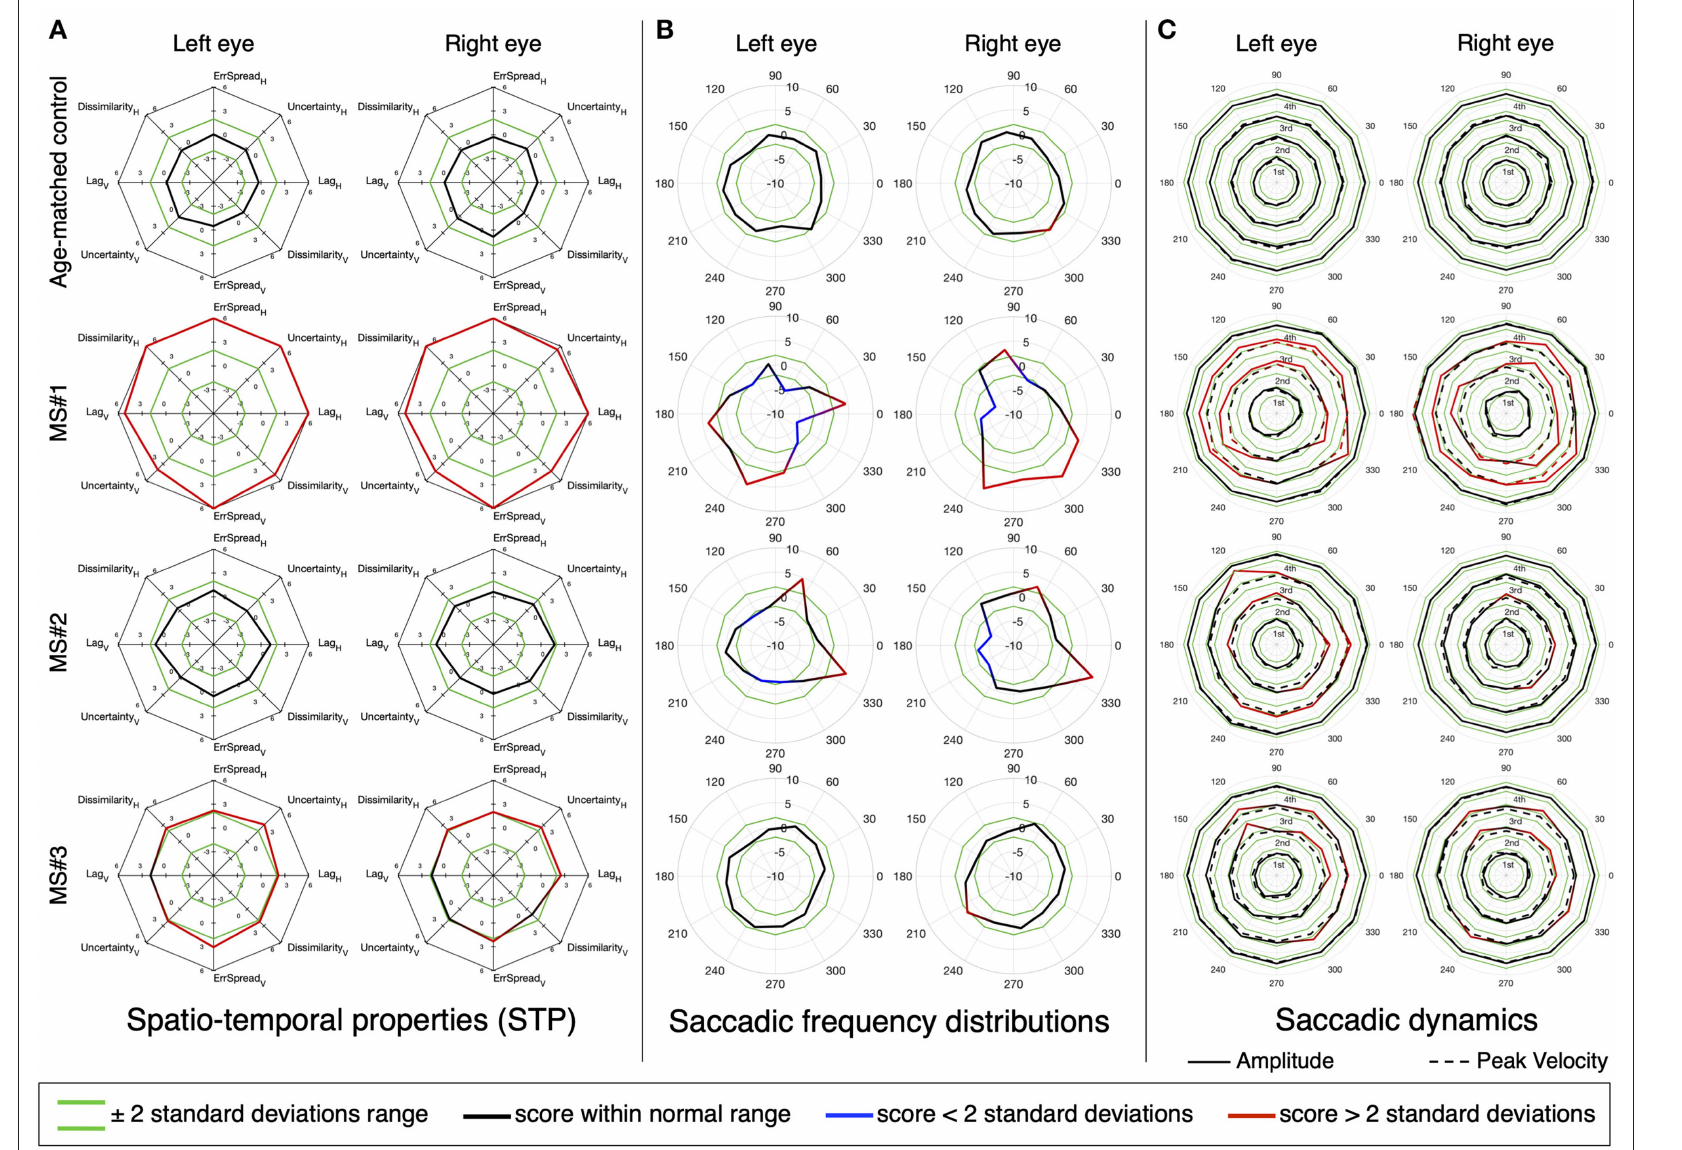
FIGURE 7 | An in-depth overview of the oculomotor performance of three MS patients, three PD patients, and two age-matched controls. (A) Normalized spatio-temporal properties (STP). We consider an STP feature abnormal if its deviates 2 or more standard deviations from the normative value (indicated in green). (B) Normalized saccadic frequency distributions. (C) Normalized saccadic dynamics (amplitude and peak velocity), as a function of saccade direction. The results are stratified per quartile, separately for amplitude and peak velocity. Each quartile has its own normative